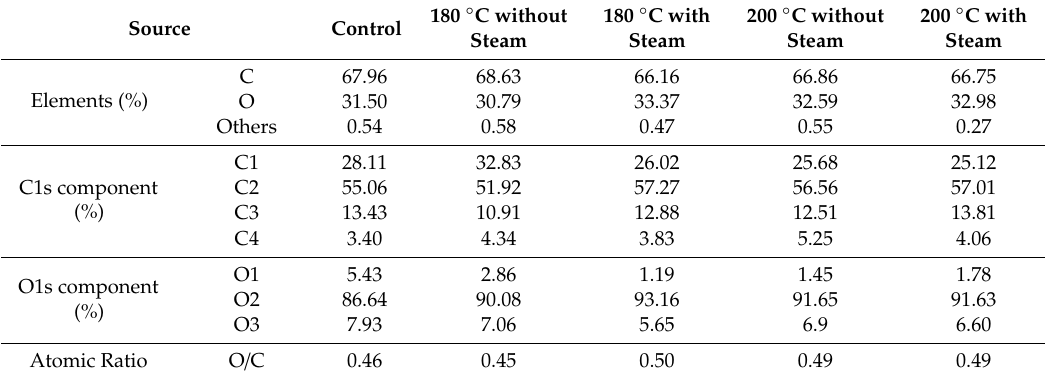
Table 1. Surface chemical element composition and oxygen / carbon atomic ratio of the studied samples.